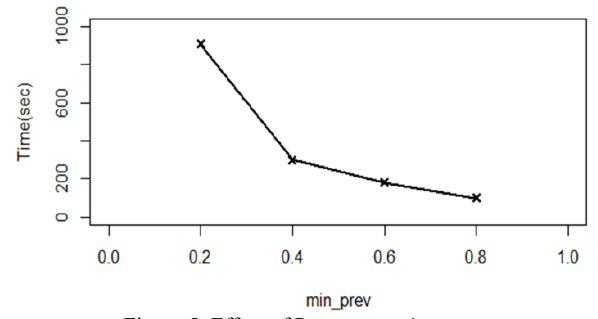
Figure 5. Effect of Parameter min_prev